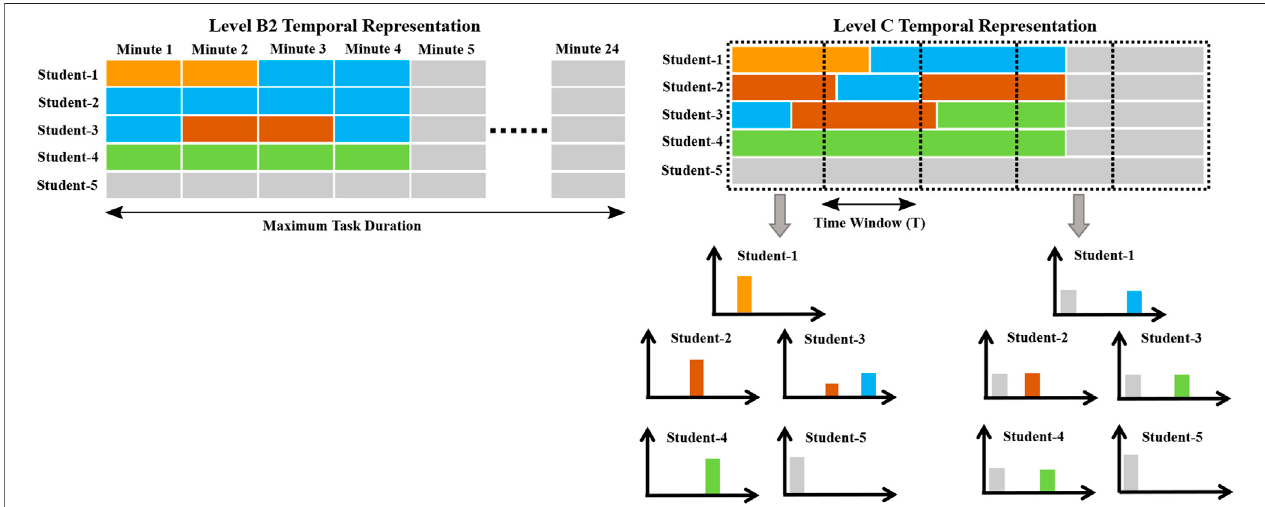
FIGURE6| LevelB2andLevelCtemporalrepresentationforagroupcontainingfourstudents.Coloredcellsrepresentthedifferentcodeslistedin Table1 ,andthe gray cells represent empty or unassigned codes.